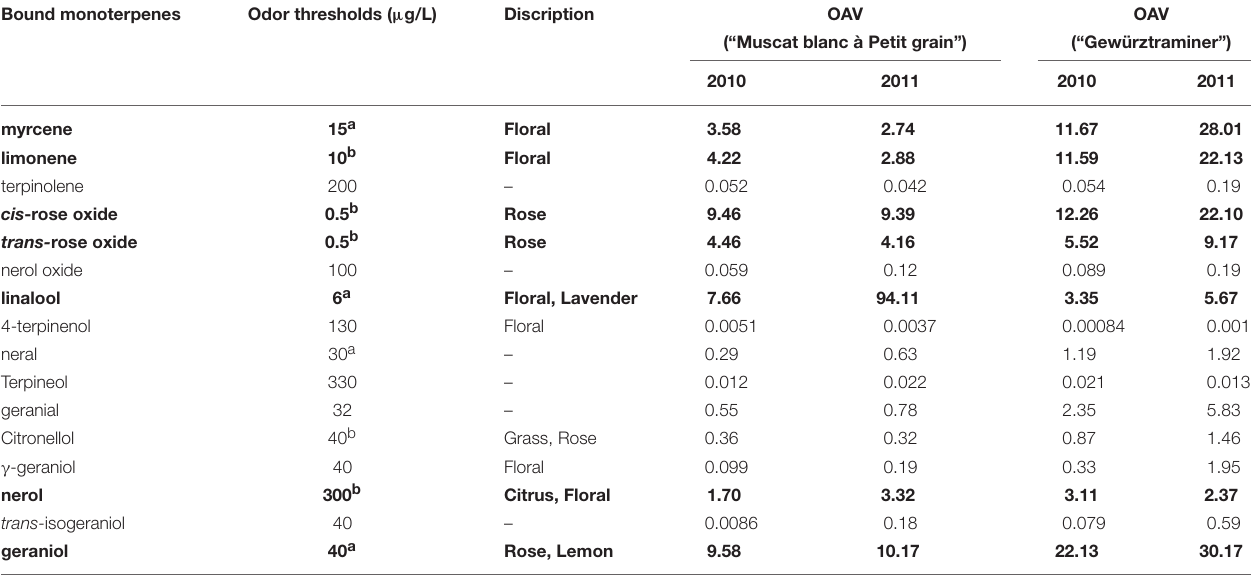
TABLE 3 | Odor thresholds and potential odor activity values (OAVs) of monoterpenyl glucosides in Vitis vinifera varieties at harvest. Bound